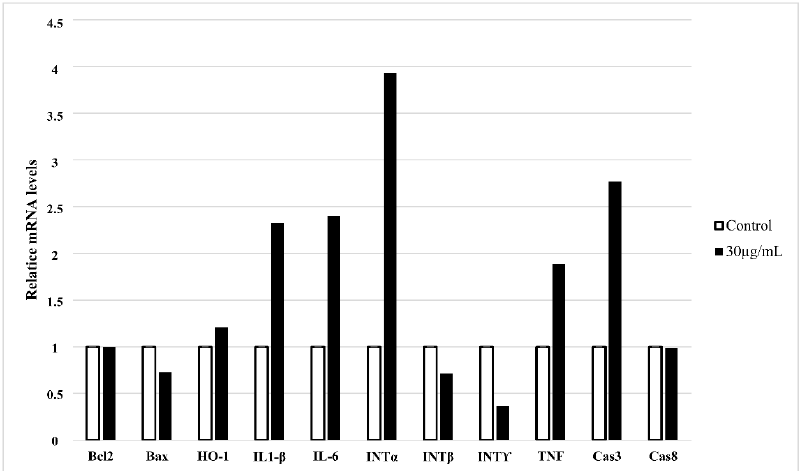
Figure 4. Quantitative RT-PCR expression analysis of apoptosis-related and inflammatory-related genes in HT-1080 cells treated with star polymer for 6h at the concentration 30 µg/mL. GAPDH was used as loading control. Values are mean ±SEM ( n = 3).